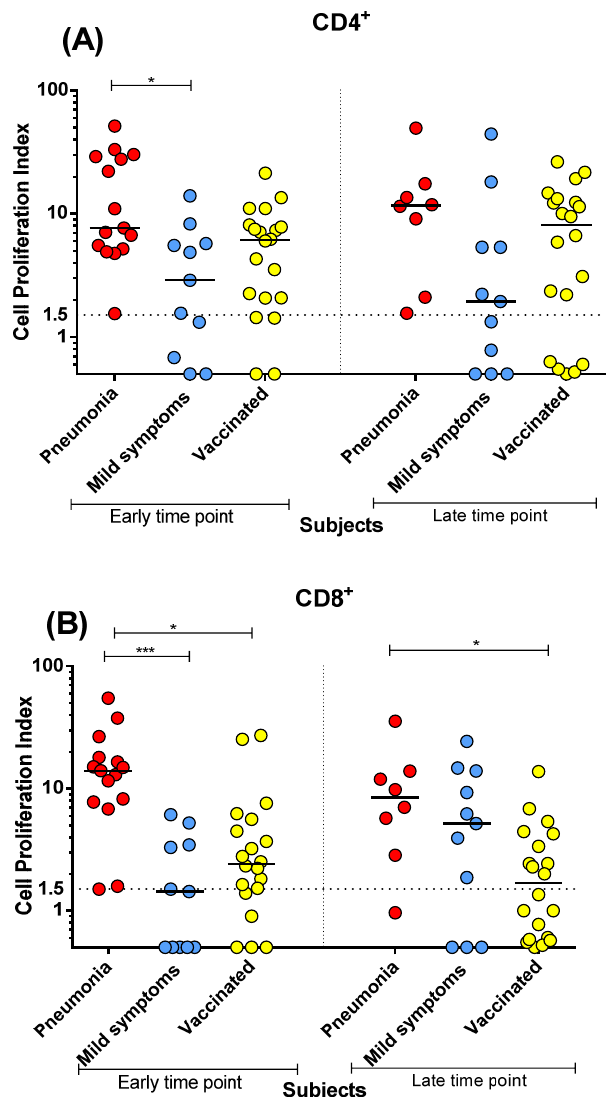
Figure 2. Spike (S)-specific T-cell response was compared between post-COVID-19 patients with pneumonia or mild symptoms and vaccinated subjects at early and late time points. ( A ) CD4 + T-cell proliferation index; ( B ) CD8 + T-cell proliferation index. Early time point: patients with pneumonia, median 59 (range 45–90) days after infection; patients with mild symptoms, 48 (24–90) days after infection; vaccinated subjects three weeks after two vaccine doses. Late time point: patients with pneumonia, median 212 (range 186–400) days after infection; patients with mild symptoms, 193 (150–306) days after infection; vaccinated subjects six months after two vaccine doses. * p < 0.05; *** p <